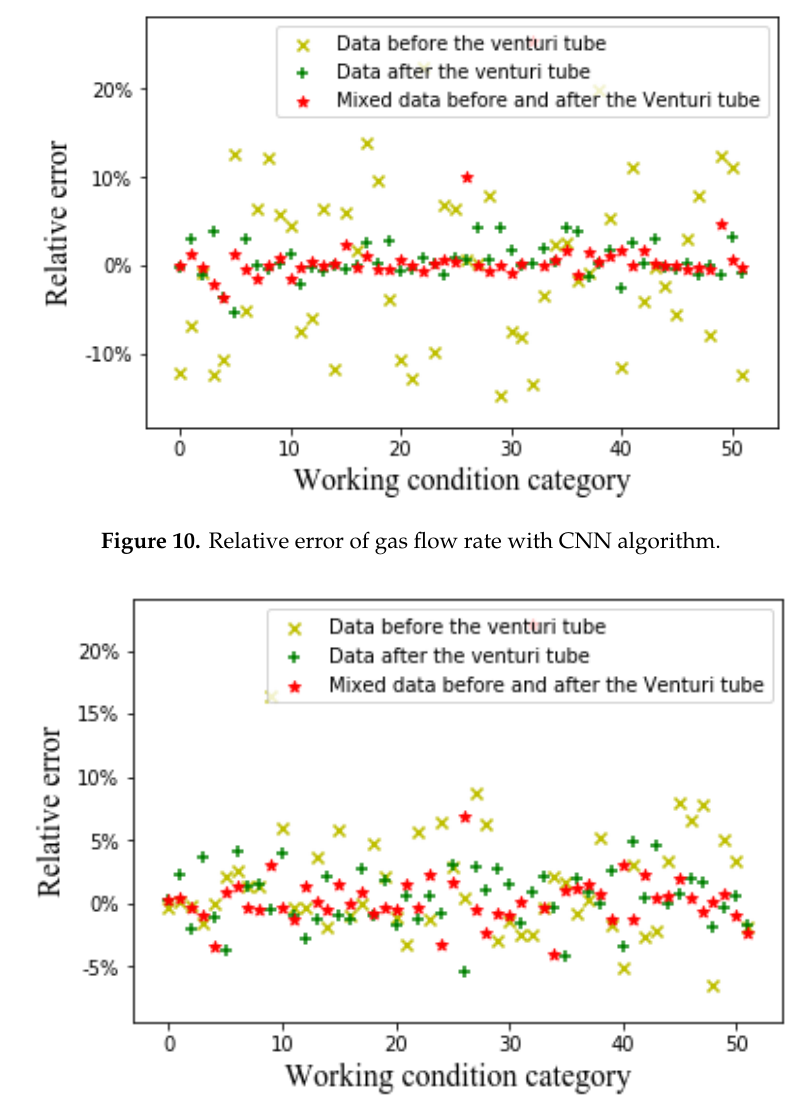
Figure 11. Relative error of GVF with CNN algorithm.